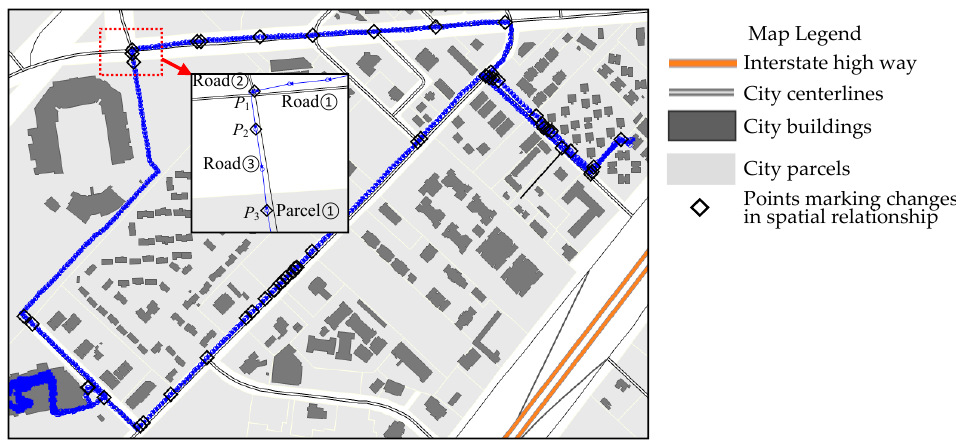
Figure 3. Critical points marking changes of spatial relationship. Note: The relationships of P 1 , P 2 and P 3 to other features are different in the above map, which are summarized in the table below. P 1 are spatially related with road and road ② . P 2 is only related to road ③ . P 3 are spatially related to road ③ and parcel ① .